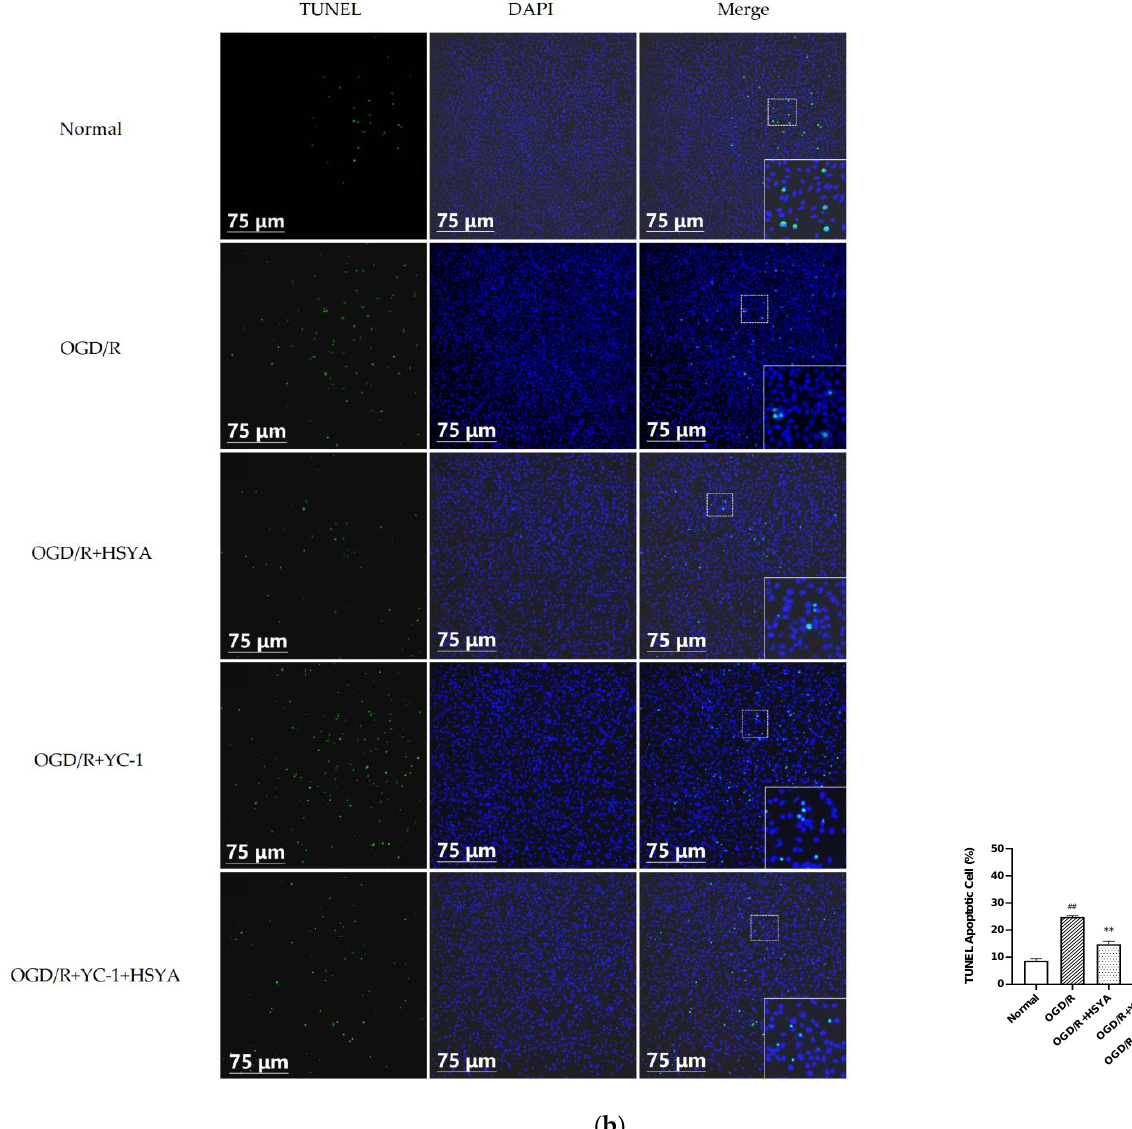
Figure 7. HIF-1 α /BNIP3 pathway regulates HSYA-induced autophagy in neuroprotection after OGD/R. ( a ) Western blotting was performed to detect the expression of LC3B, Beclin-1, P62, Bcl-2, BAX, and Cleaved-Caspase-3 after YC-1 pretreatment. GAPDH was used as an internal control. ( b ) Representative images of TUNEL assays are shown. TUNEL-positive cells are green; nuclei are blue. Results are representative of three independent experiments, and the data were statistically ana- lyzed using one-way ANOVA and expressed as mean ± standard deviation. (Note: compared with the normal group, ### p < 0.001, ## p < 0.01; compared with the OGD/R group, *** p < 0.001, ** p < 0.01, * p < 0.05.)